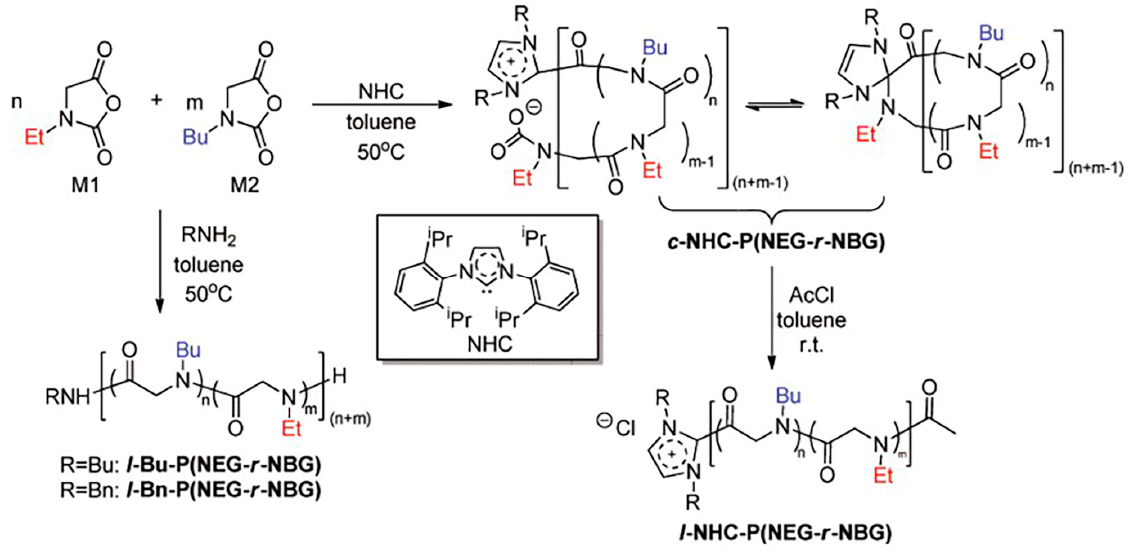
Figure 3. Synthesis of cyclic and linear random copoly( α -peptoid)s that have thermal-response properties in aqueous solution. Reprinted with permission from [69]. Copyright 2012, American Chemical Society.